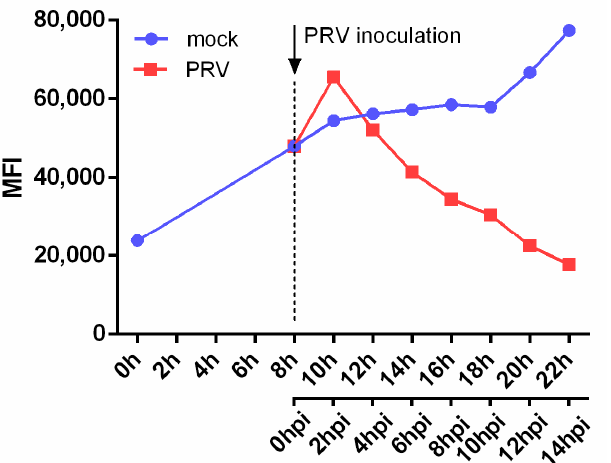
Figure 2. Time course of the effect of PRV or mock inoculation on NKG2D binding to SK cells. SK cells were cultivated in suspension for 8 h before mock or PRV inoculation. At different time points, as shown in the graph, SK cells were incubated with recombinant Fc-tagged human NKG2D protein and analyzed using flow cytometry. The graph shows the median fluorescence intensity (MFI) for each condition. Representative graph of 2 independent experiments is shown, n = 2.